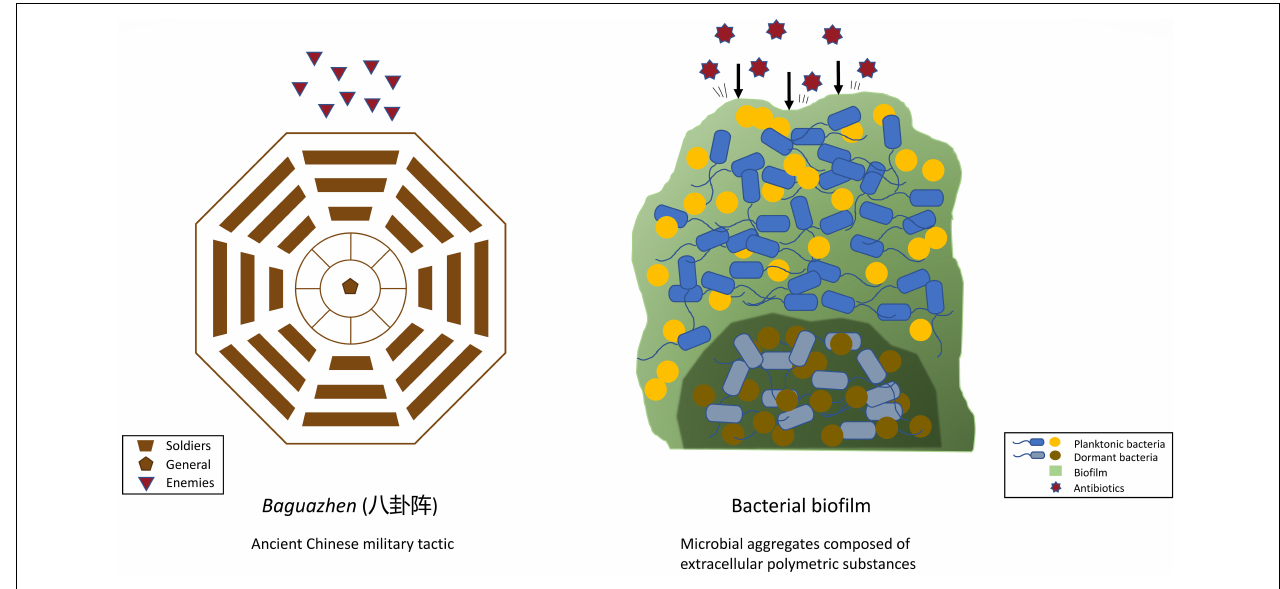
FIGURE 1 | Comparing the structural mechanism of ancient Chinese military tactics and bacterial